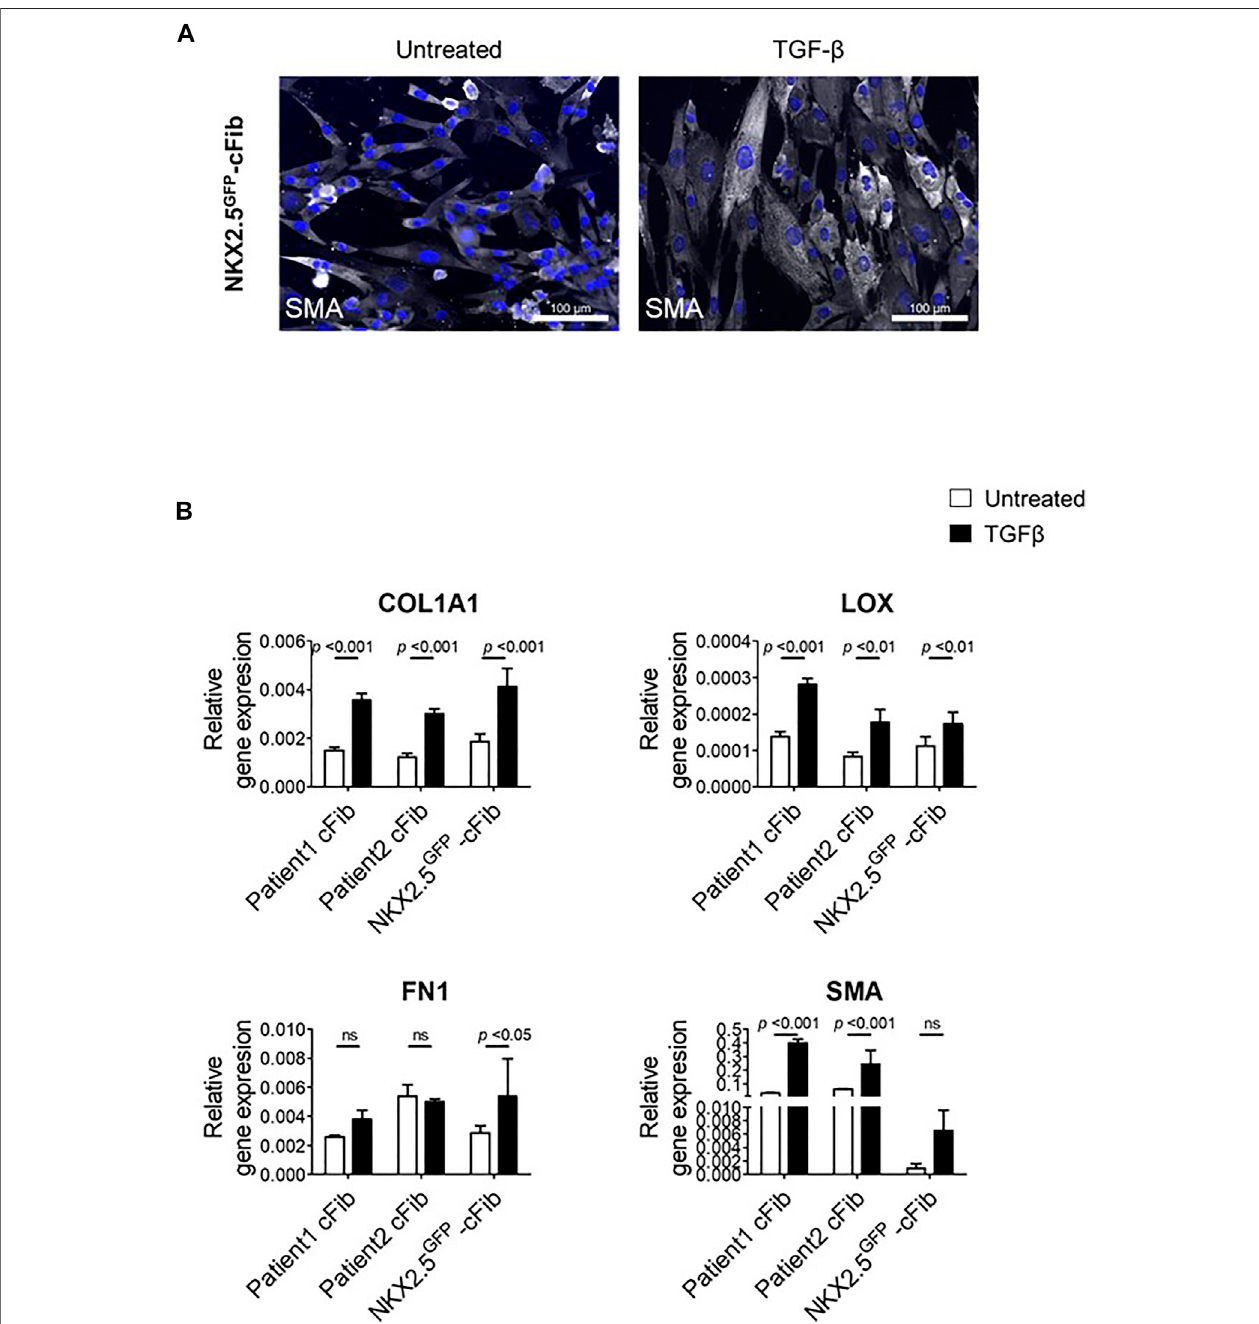
FIGURE4| FibroblastactivationassaysinNKX2.5 GFP -cFib. (A) Immunostaininganalysisof α SMA(inwhite)inNKX2.5 GFP -cFibnon-treatedandtreatedwith10 ng/ mlTGF β for48 h.Nuclei:DAPI.Scalebars,100 µm (B) Geneexpressionanalysisofactivated fi broblastmarkers(COL1A1,LOX,FN1,SMA)inNKX2.5 GFP -cFibandcFib derived from two different patients, non-treated (white bars) and treated (black bars) with 10 ng/ml TFG β for 24 h. Three biological replicates were included in NKX2.5 GFP -cFib data, and three technical replicates in the case ofpatient-derived cFib.Mean ± S.D. ofeach data group are represented; non-treated vs treated p values are shown using a 2 way ANOVA